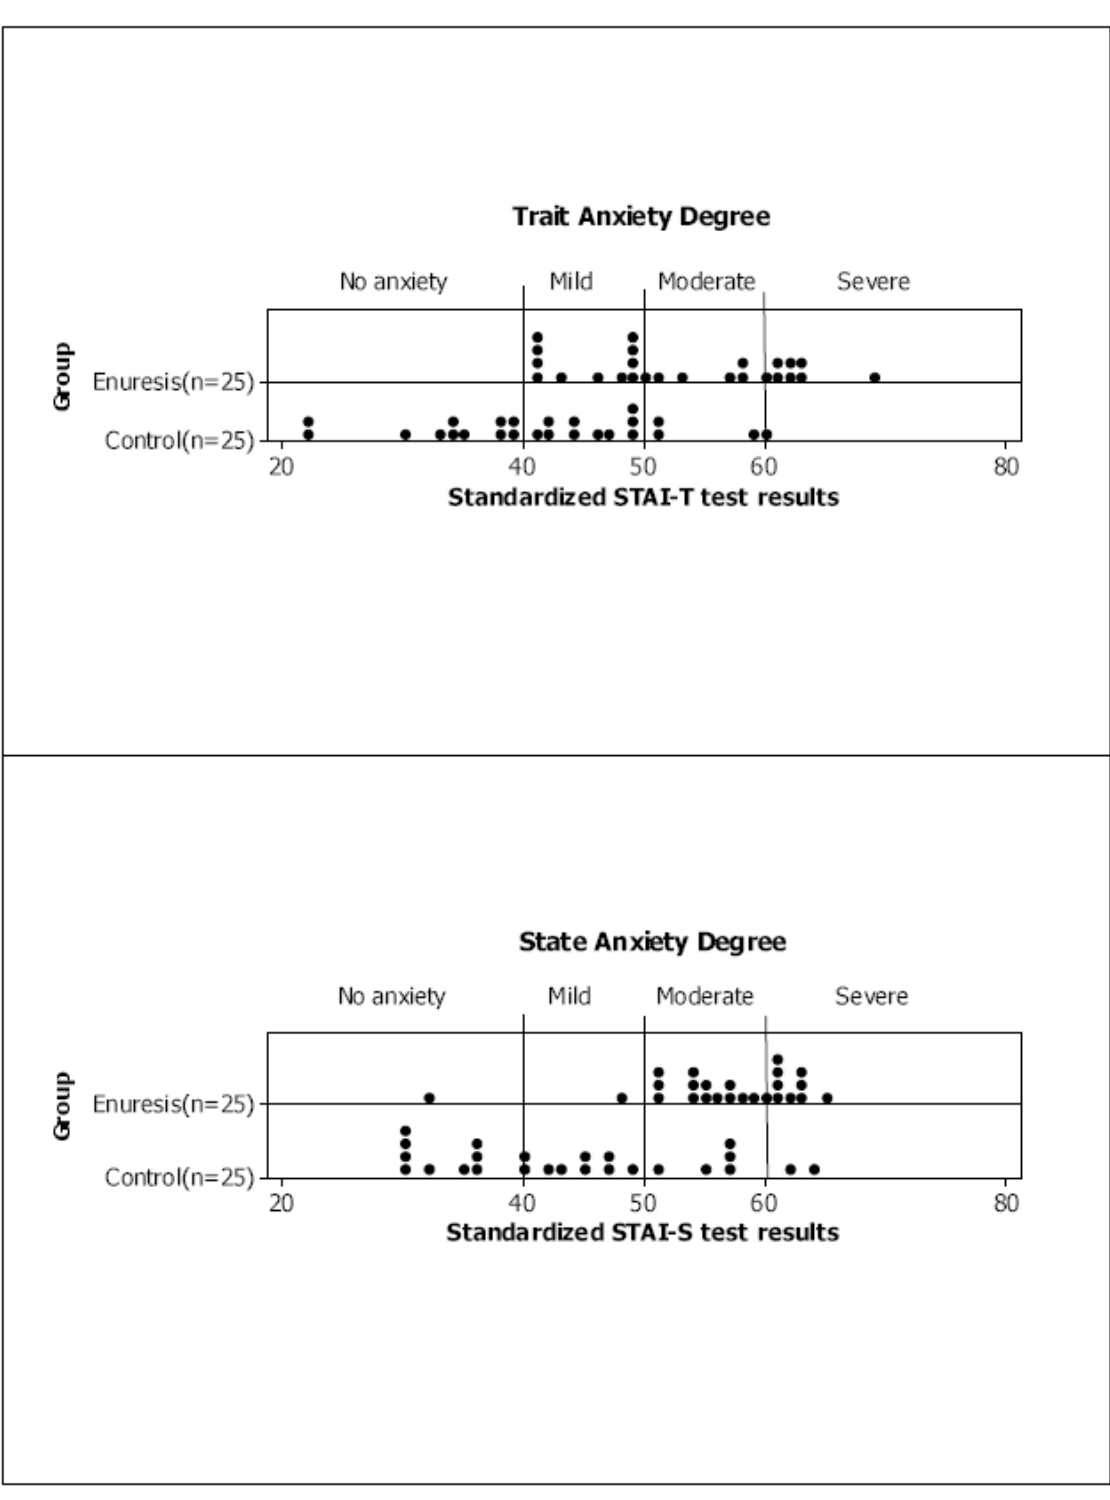
Figure 1. Representation of the mothers’ degree of anxiety based on the standardized STAI-T and STAI-S test results per group. Table 2. Trait anxiety and state anxiety frequencies in each group.